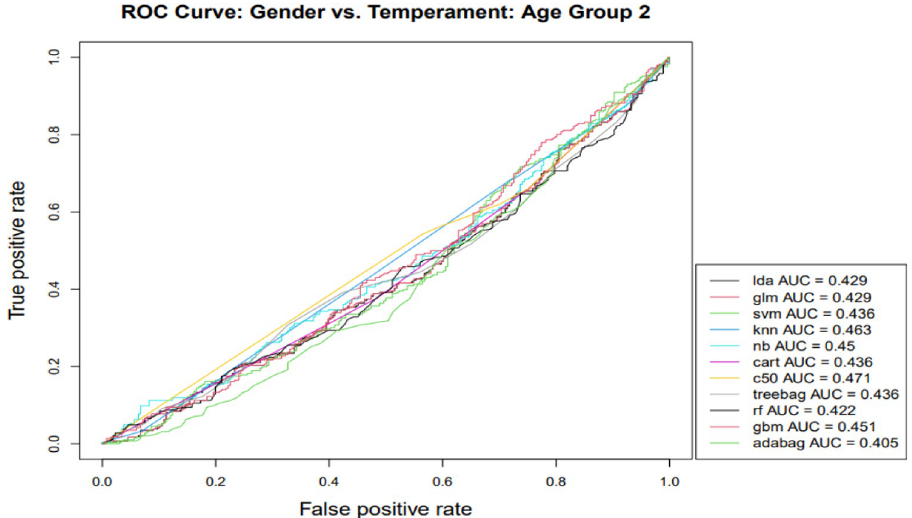
Fig 2. Note: lda—Linear Discriminant Analysis; glm—Generalized Linear Modeling; svm—Support Vector Machines; knn—K-Nearest Neighbor; nb—Na ï ve Bayes; cart—Classification and Regression Trees; c50—C5.0 Classification; treebag—Bootstrapped Aggregated Trees; rf—Ensembled Decision Trees (Random Forest); gbm— Gradient Boosting Method; adabag—Multi-class Adaptive Boosting